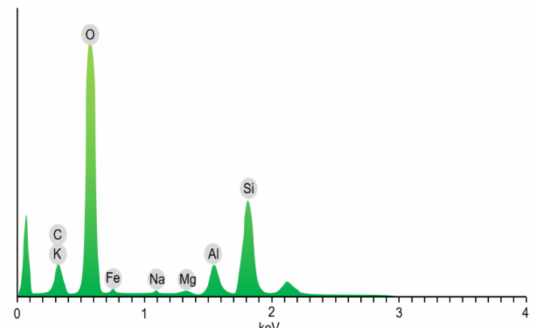
Figure 3. EDS results for mudstone samples.